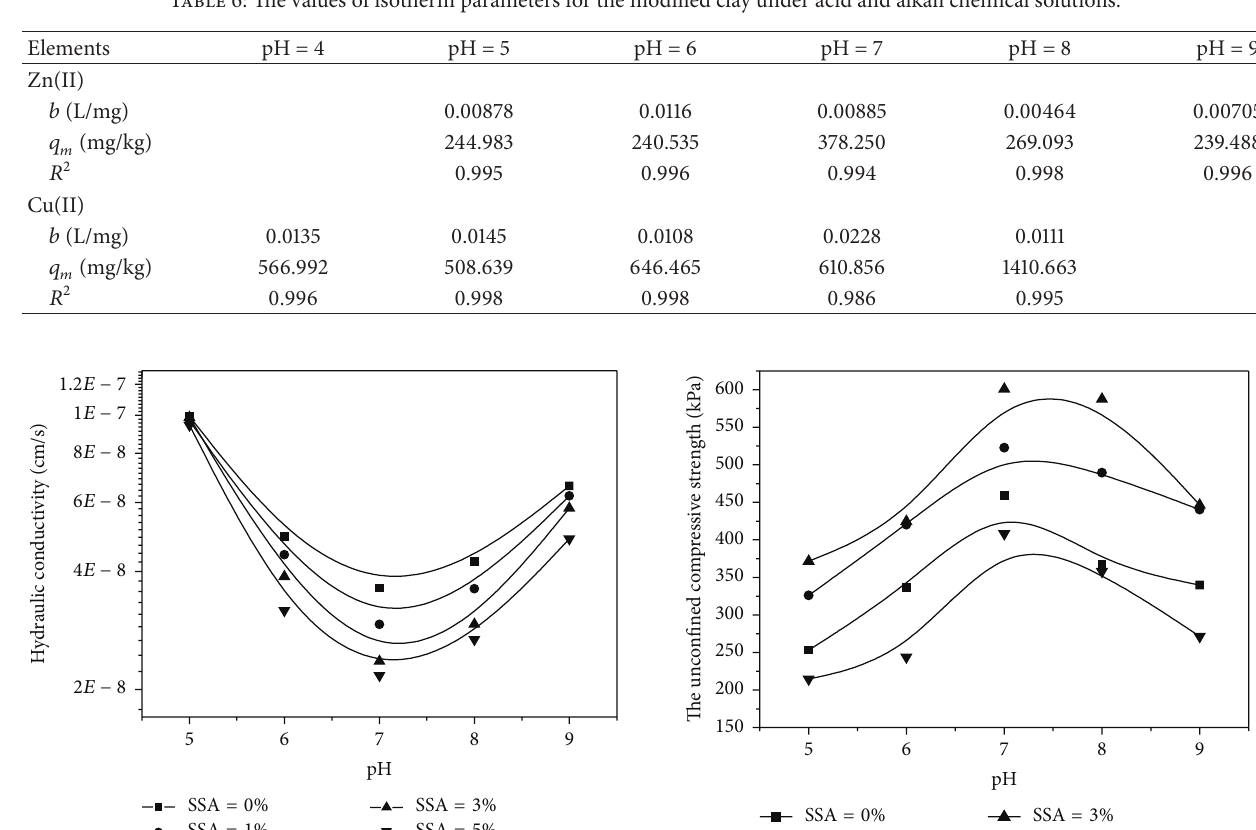
Table 6: The values of isotherm parameters for the modified clay under acid and alkali chemical solutions.